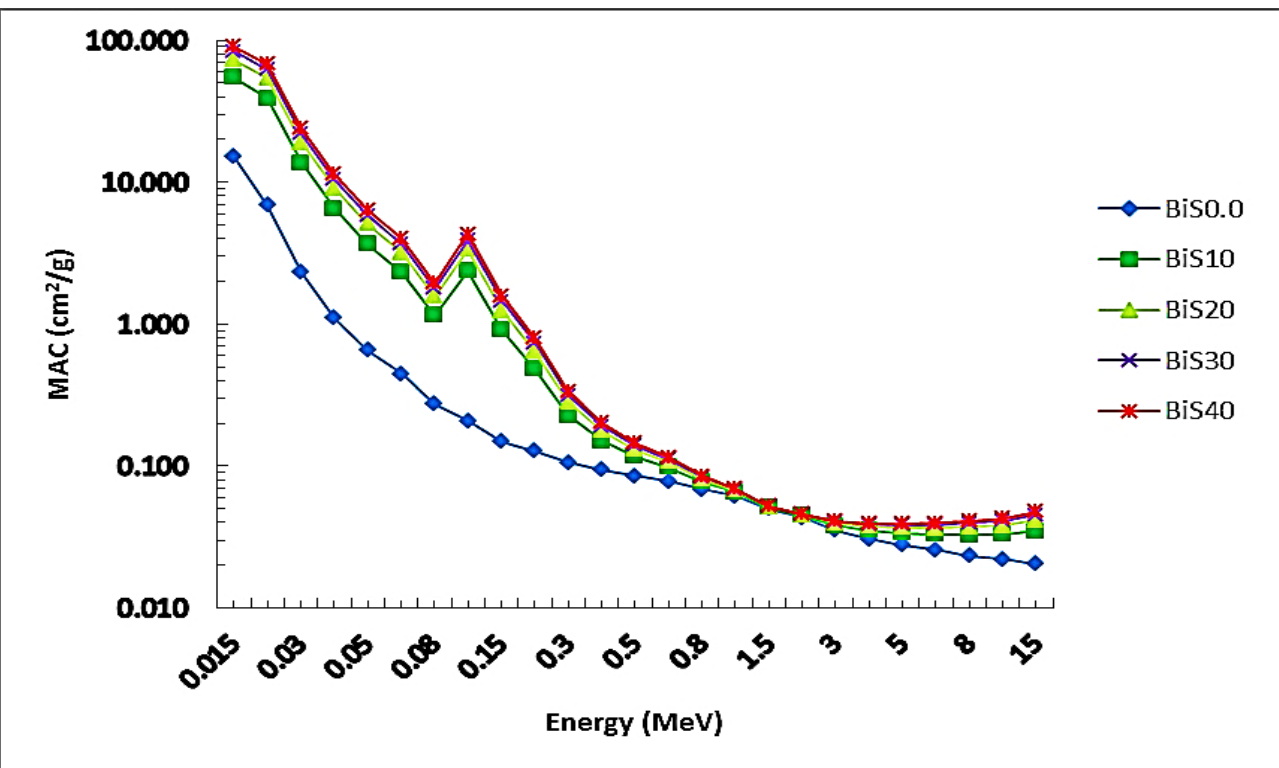
Figure 6. MAC values depending on the photon energy for all glass samples.